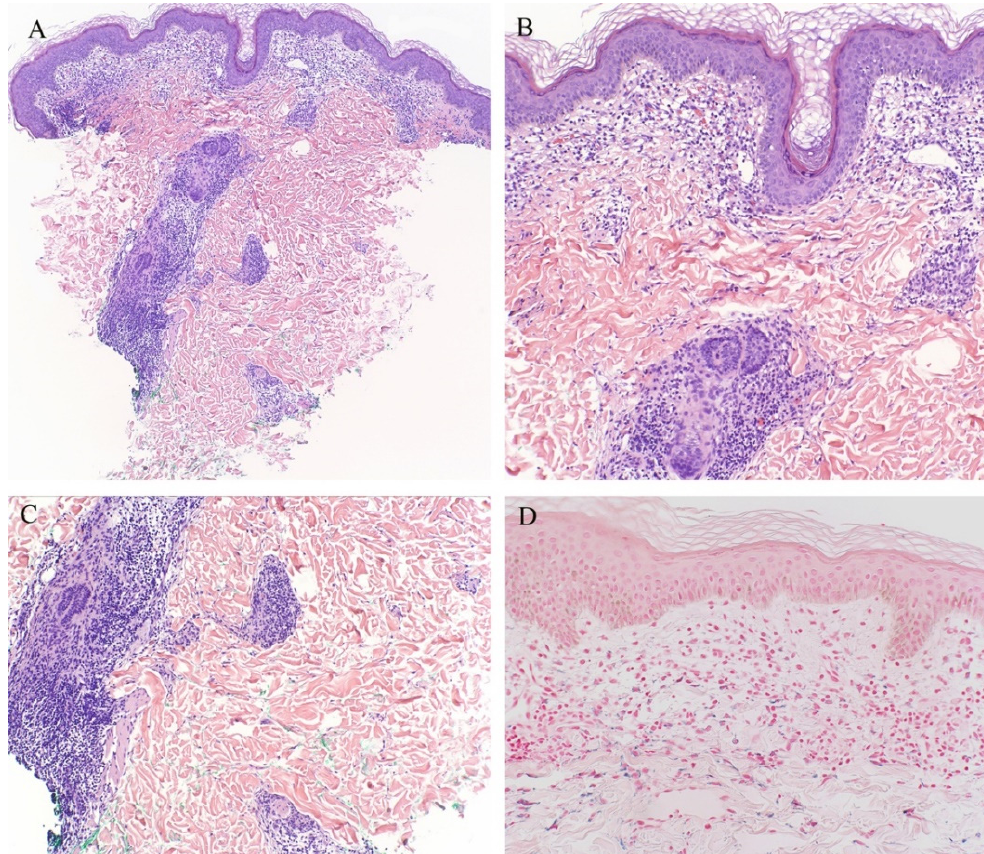
Figure 9. ( A – C ) Lichen aureus with periadnexal inflammation; ( D ) Iron stain.